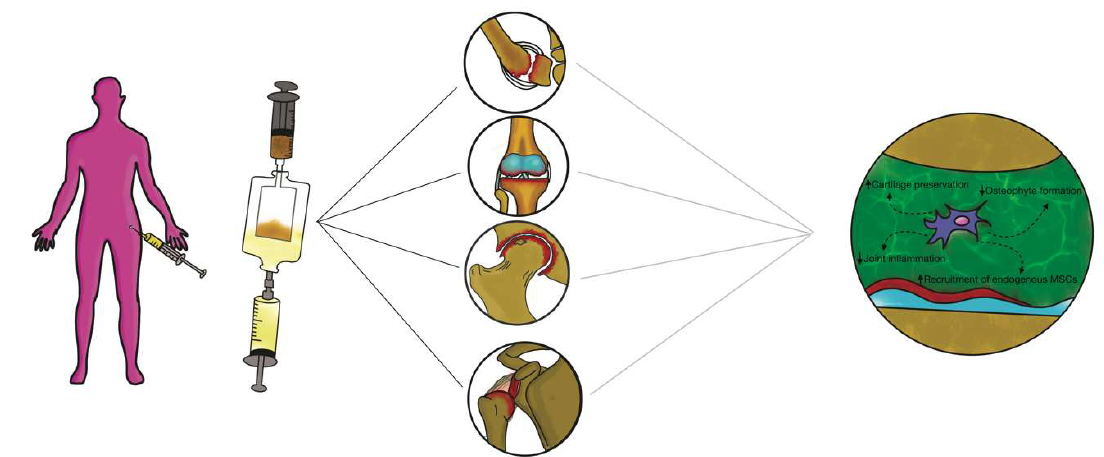
Figure 4. Non-enzymatic procedures have been proposed including mechanical dissociation of adipose tissue using automated closing devices and non-operator-dependent tools.